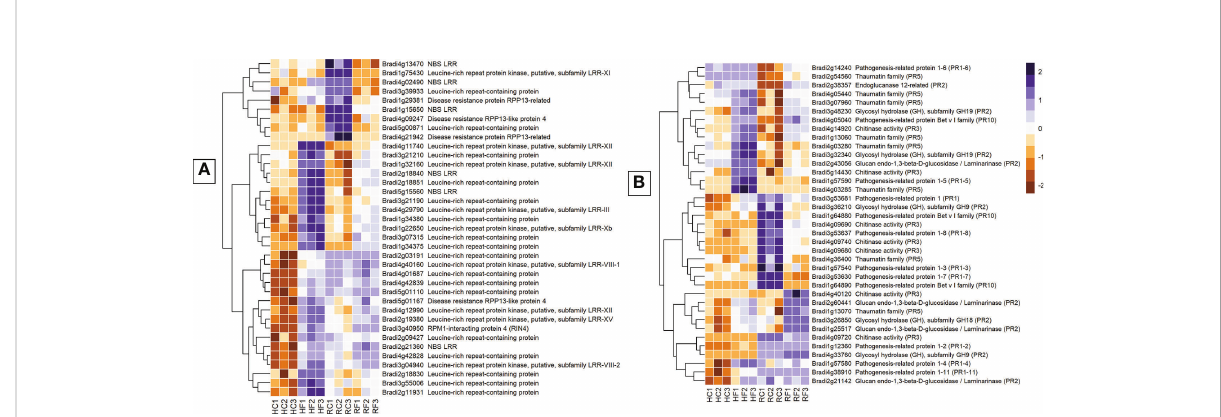
FIGURE 4 The most expressed or repressed receptor-related (A) and defence-associated (B) B. distachyon genes. These genes showed a log-fold change of -3 ≤ Log2 ≥ 3 (A) and -2 ≤ Log2 ≥ 2 (B) with a p-adj < 0.05 in response to either FHB, FRR, or both. A more restrictive Log-fold threshold is used for (A) due to a larger number of signi fi cantly expressed or repressed receptor-related genes. The scale bar on the right is the Z-score for all the heatmaps. Three biological replicates for each of the four treatments are displayed as columns abbreviated as HC (Head-FHB control), HF (Head-FHB fungus), RC (Root-FRR Control), RF (Root-FRR fungus). The control samples (HC1-HC3, RC1-RC3) are normalised transcript counts from mock inoculated head (Water with Tween 20) and root (PDA slurry) B. distachyon tissues and were separately analysed through the RNA-seq pipeline with the respective inoculated sample